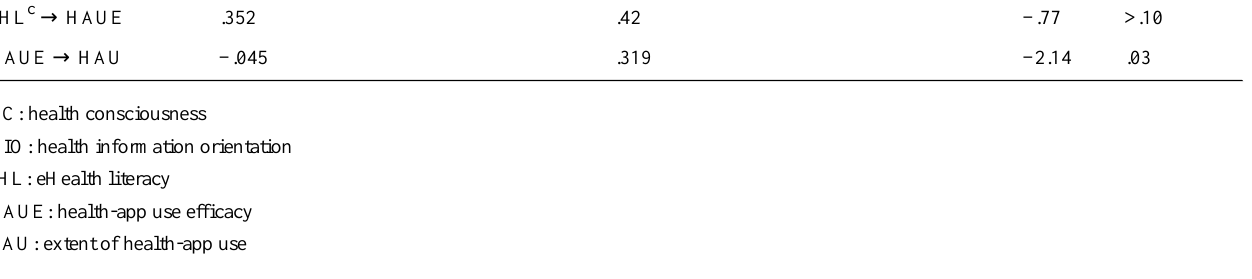
Figure 1. Initial path model of main study variables with entire sample. HC: Health Consciousness; HIO: Health Information Orientation; eHL: eHealth